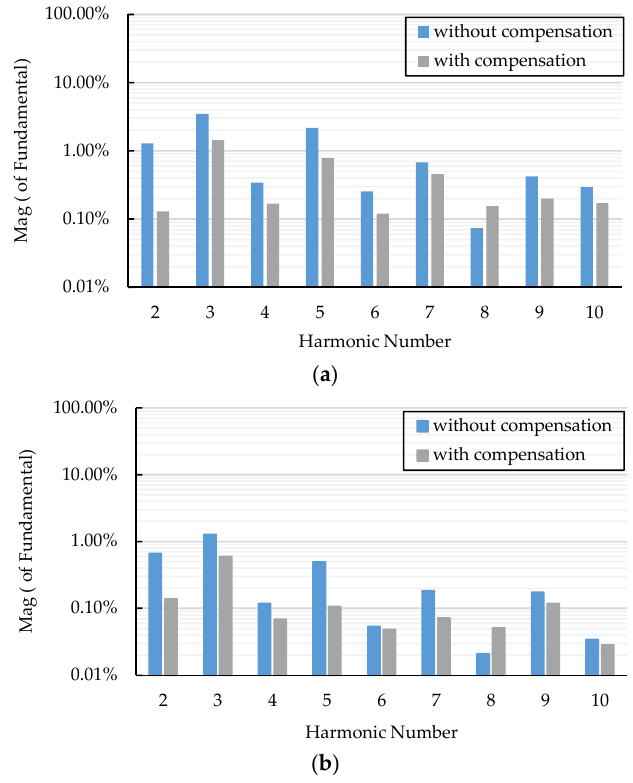
Figure 17. Magnitudes of the 2nd–10th harmonic components in respect to the fundamental component ( a ) output voltage; ( b ) output current.